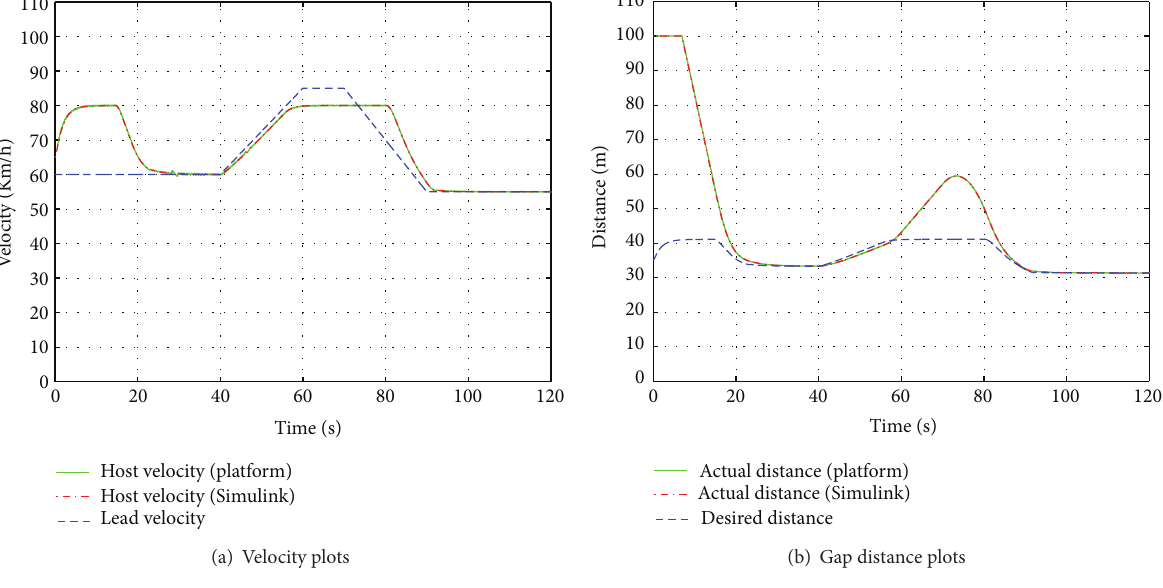
Figure 12: Gap Distance and Velocities.